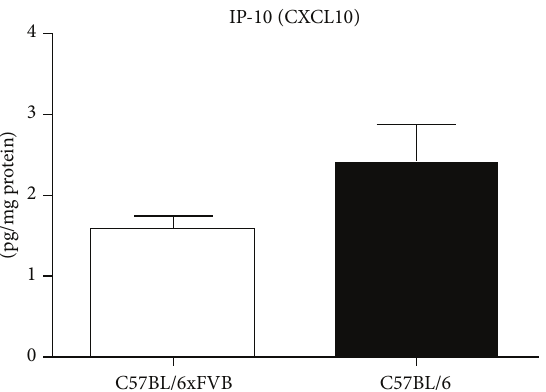
Figure 5: Concentrations of selected cytokines in gastrocnemius muscle. Concentration of VEGF was higher in C57BL/6J mice than in C57BL/6JxFVB mice. Concentrations of GM-CSF, bFGF, IL-1 𝛼 , IL5, IL10, MCP-1, KC, and IP-10 did not differ between C57BL/6J and C57BL/6JxFVB